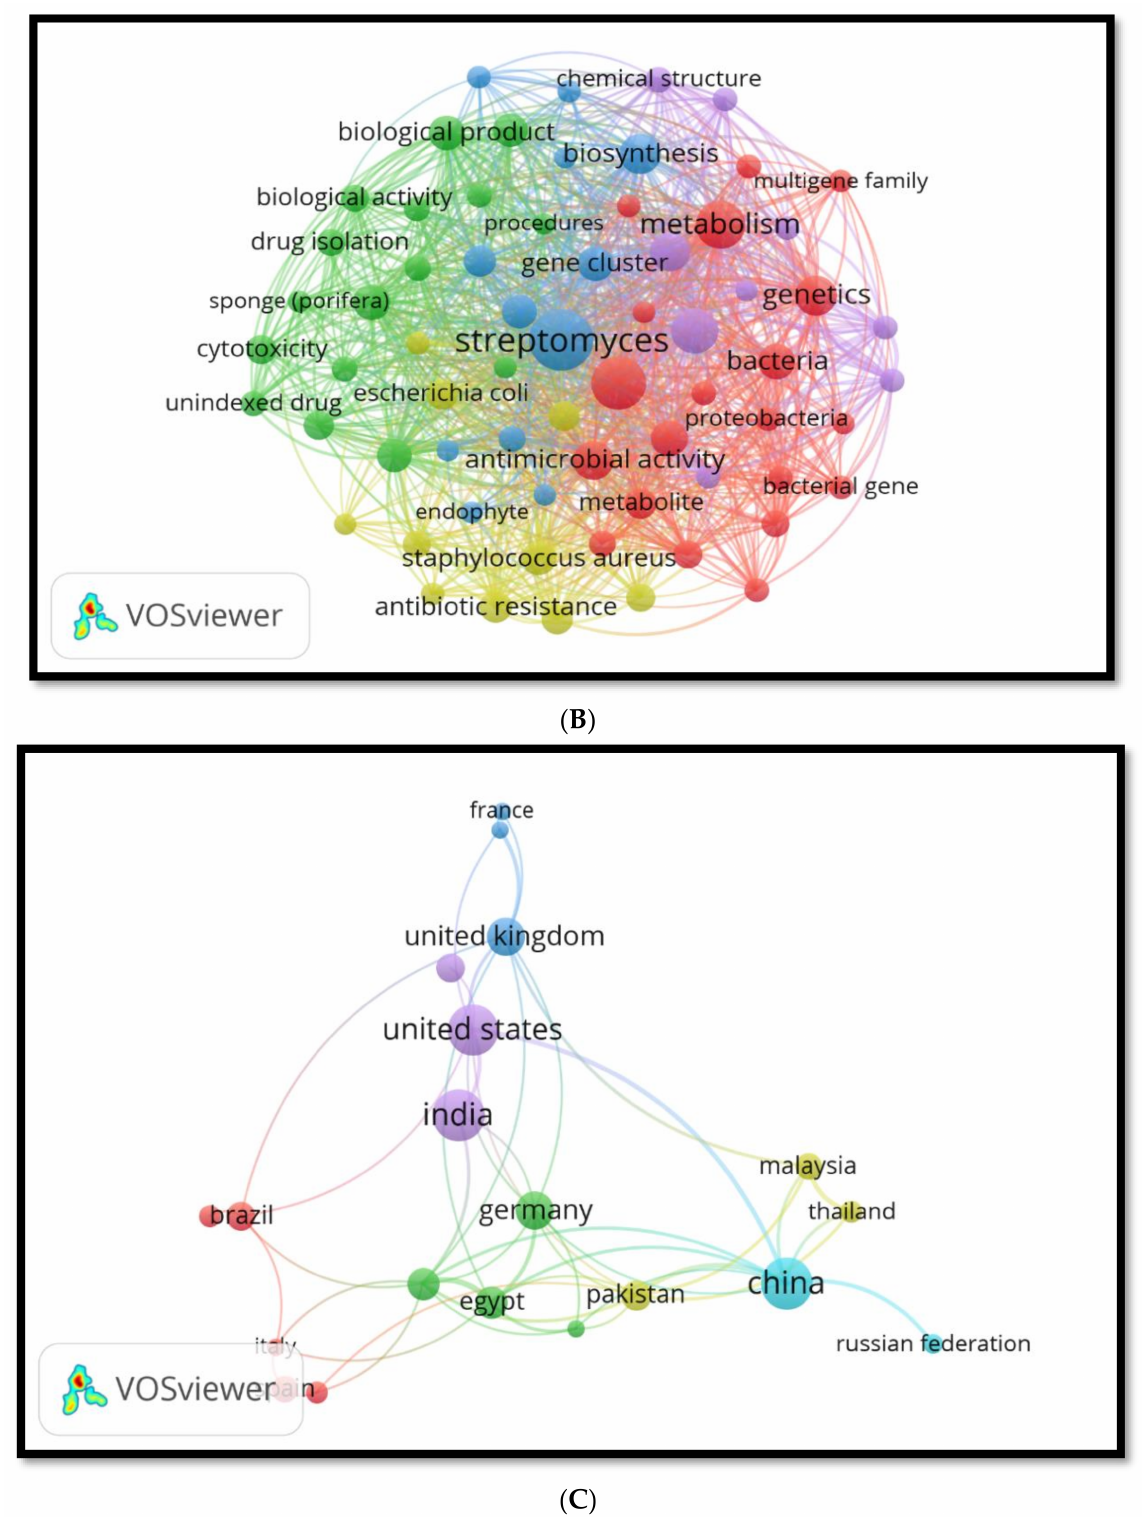
Figure 2. VOSviewer software tool to analyse and visualise scientific literature from 2010 to 2021 for phylum Actinobacteria. ( A ) Diversity of keywords from the Scopus database for Streptomyces , Actinobacteria, natural products, primary,